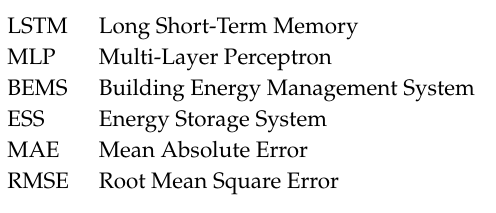
Table 4. Effect of parameters P